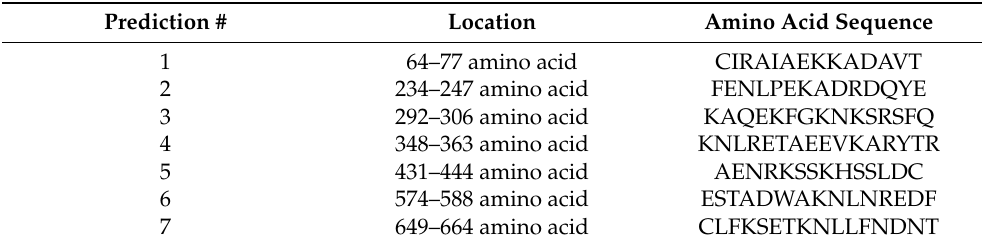
Table 1. Prediction of protein antigenic determinants based on antigenicity and hydrophobicity from bLF amino acid sequences.